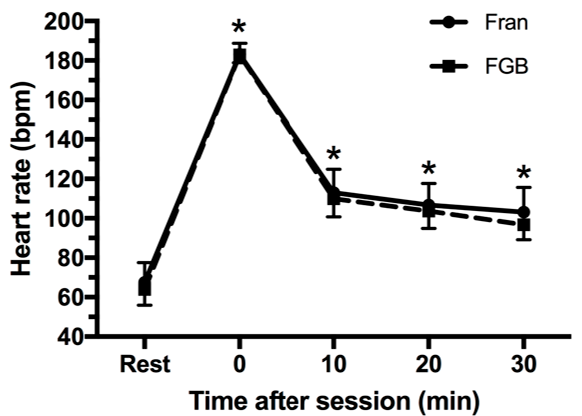
Figure 4. Heart rate (HR) before and after CrossFit ® sessions. * p ≤ 0.05 for rest for the two CrossFit ® sessions.